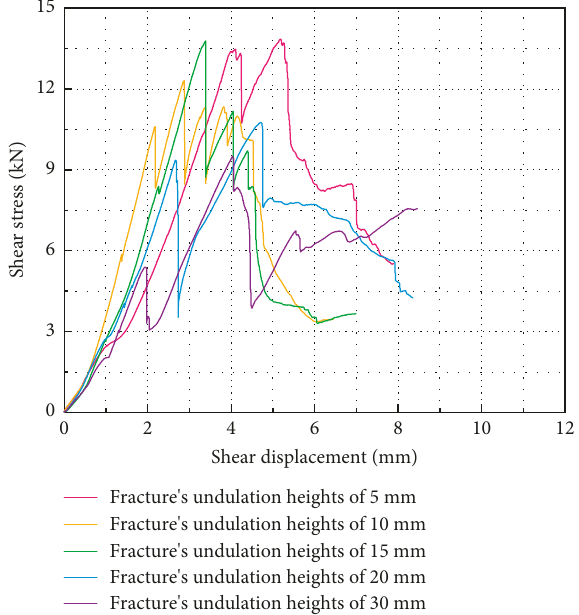
Figure 6: Shear stress-shear displacement curves of specimens with fractures having different undulated